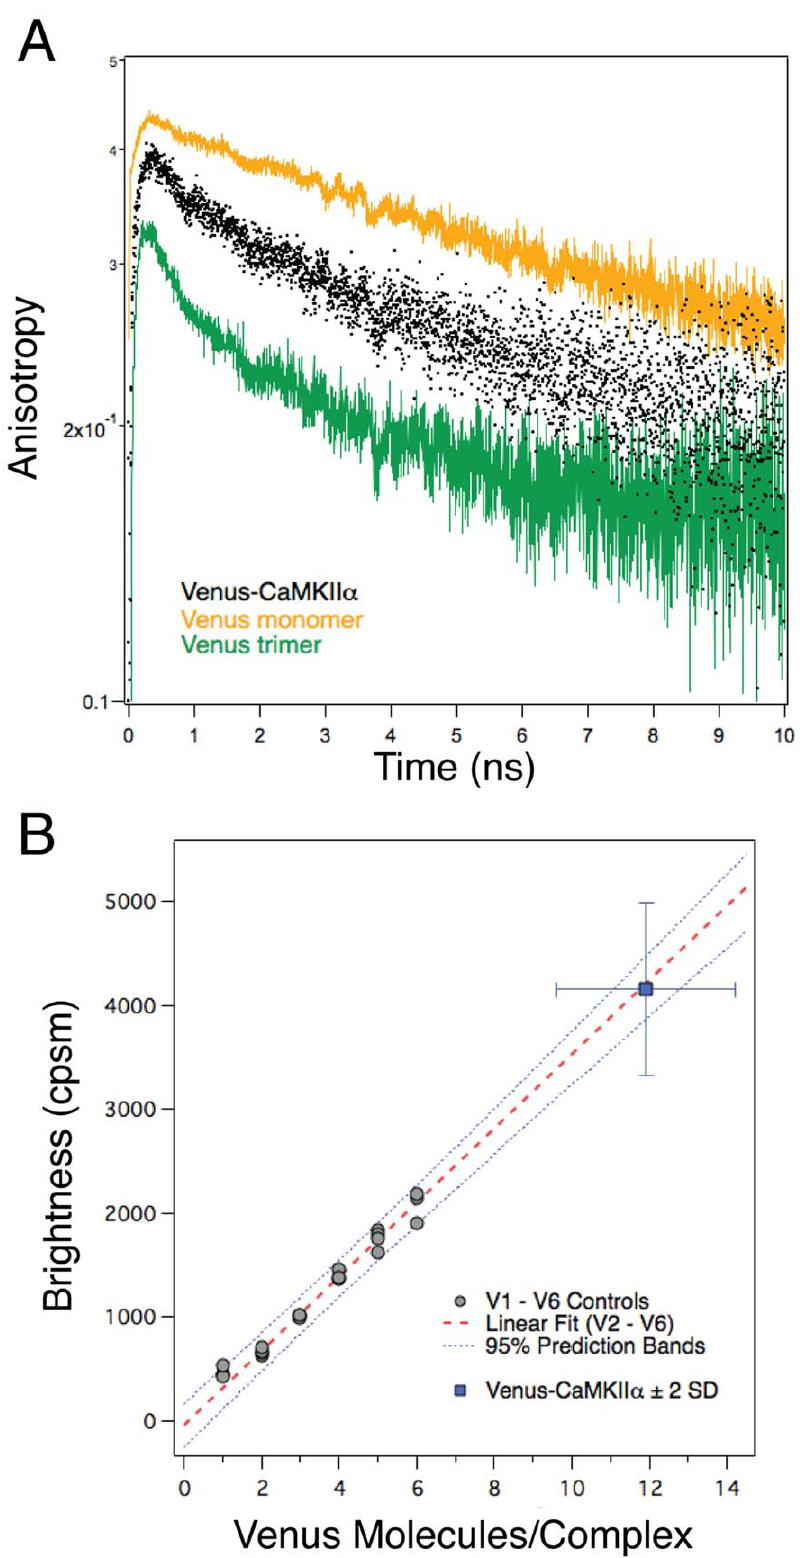
Figure 4. FPFA of V-CaMKII a expressed in HEK cells. (A) Average TRA for V-CaMKII a (Black) holoenzyme in cells. TRA traces for Venus monomers (V1, Yellow) and Venus trimers (V3, Green) expressed in HEK cells are also plotted as a reference, and to illustrate that the Venus-tagged catalytic domains in V-CaMKII a produce an anisotropy signal most consistent with Venus-dimers. The excitation power used was 6 mW. (B) The brightness values for V1–V6 expressed and measured in HEK cells are plotted as a function of the number of Venus molecules in each construct. Each